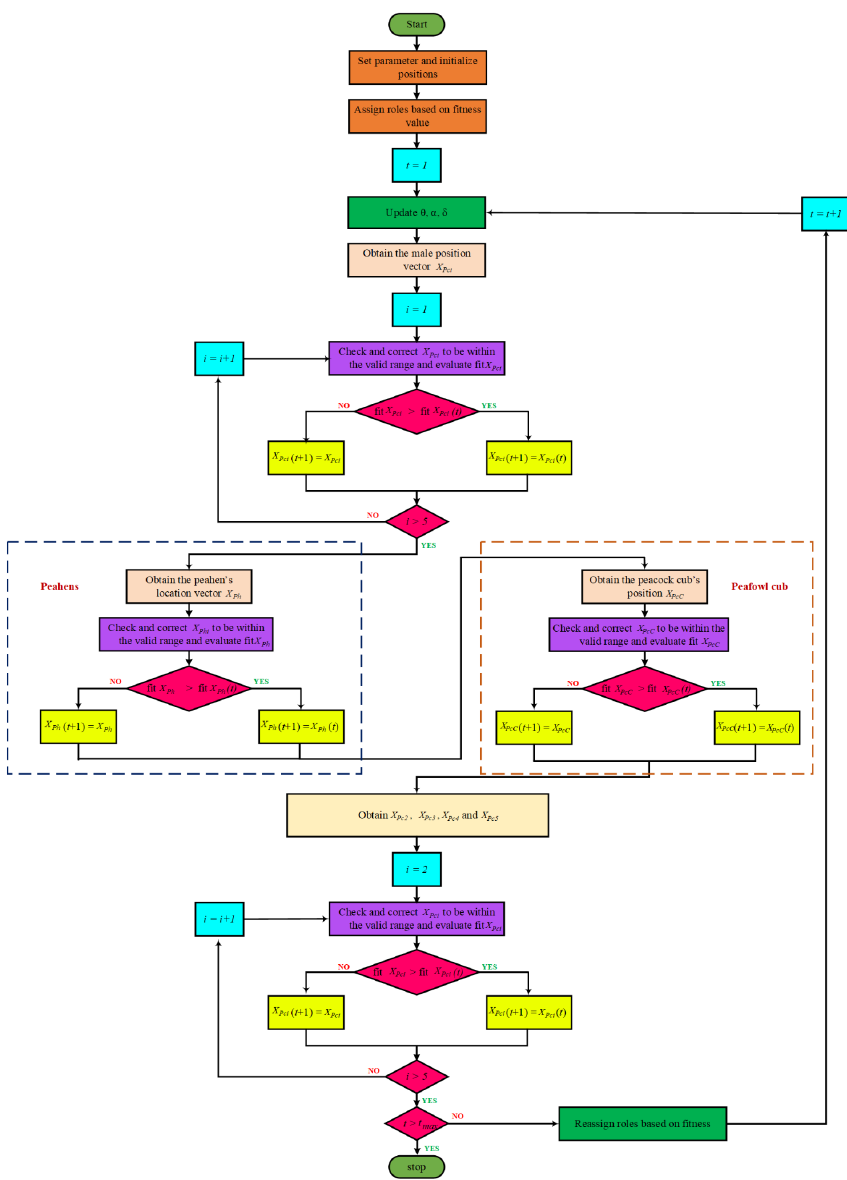
Figure 1. Flowchart of POA for the OPF problem.